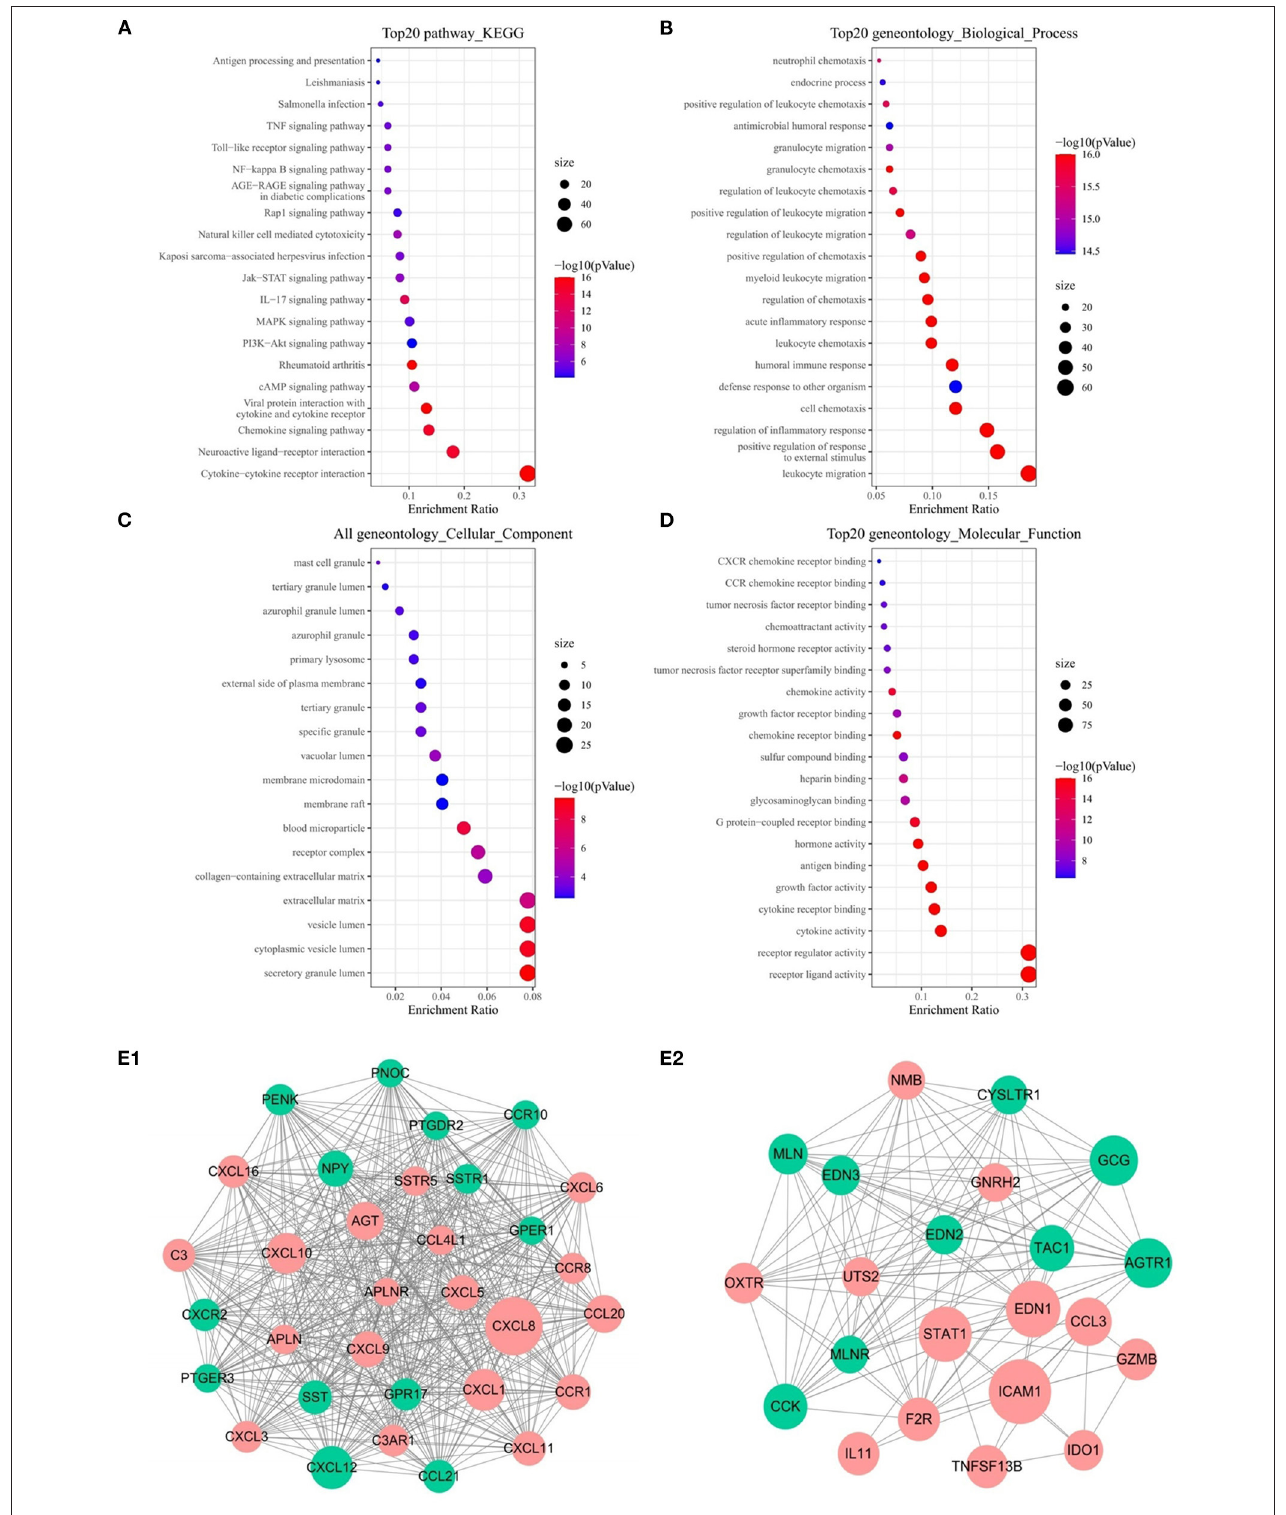
FIGURE 2 | Functional enrichment analysis of 357 DEIRGs and significant modular analysis based on PPI network. Top 20 KEGG terms (A) . Top 20 GO terms of GO: BP (B) . Top 20 GO terms of GO: CC (C) . Top 20 GO terms of GO: MF (D) . PPI network of the APLNR module (E1) . PPI network of the STAT1 module (E2) . In A, B, C and D, terms are sorted by the number of genes enriched. In (E1,E2) , red stands for up-regulated and green stands for down-regulated genes. The size of the node represents the number of proteins that interact with the specified protein.